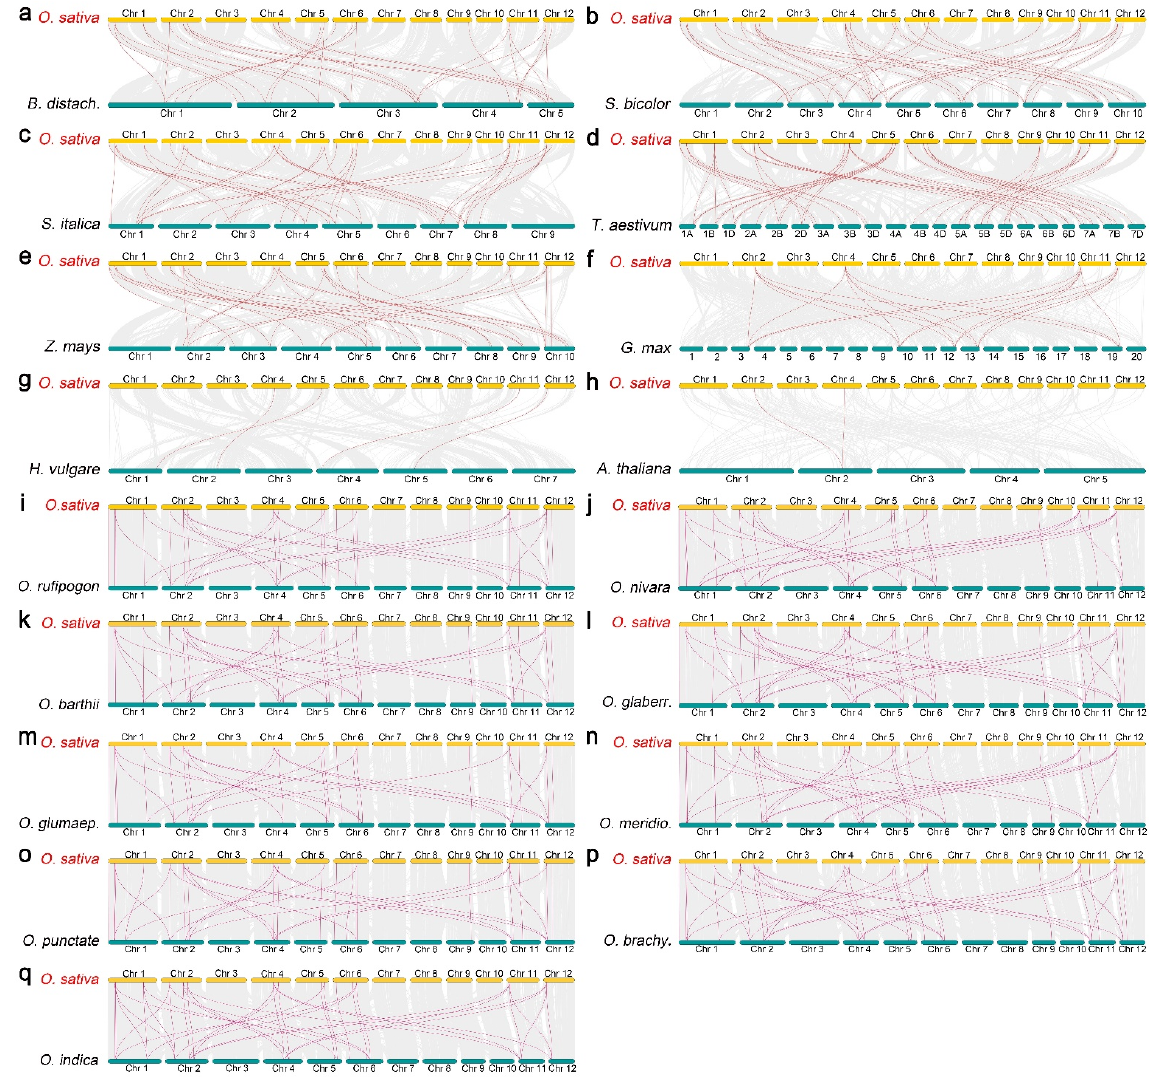
Figure 6. Syntenic analysis of PEBP genes between rice and other crops. ( a – h ) Collinear pairs between rice and crops, including brachypodium ( a ), sorgum ( b ), millet ( c ), wheat ( d ), maize ( e ), soybean ( f ), barley ( g ), and Arabidopsis ( h ). ( i – q ) Colinear pairs between rice and 8 wild rice species, including Oryza rufipogon ( i ), Oryza nivara ( j ), Oryza barthii ( k ) , Oryza glaberrima ( l ) , Oryza glumaepatula ( m ) , Oryza meridionalis ( n ) , Oryza punctate ( o ) , Oryza brachyantha ( p ) , and cultivated indica rice ( Oryza indica ) ( q ). The gray lines at the bottom represent the collinear regions in rice and other genomes. The red lines represent the pairs of PEBP